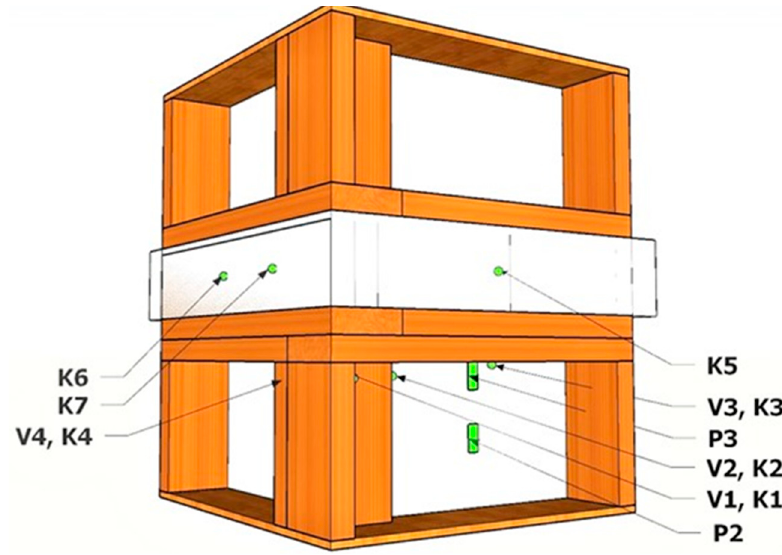
Figure 8. Schematic marking and positioning of sensors.